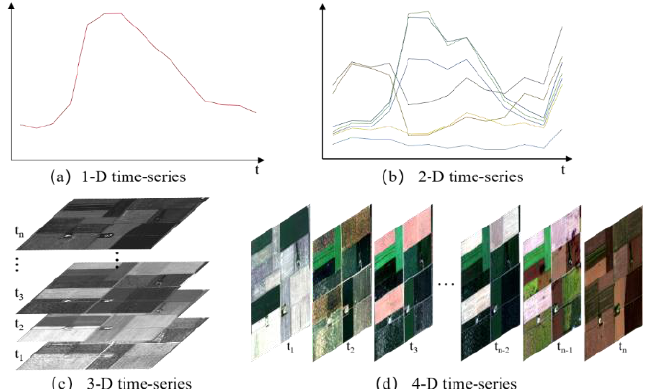
Figure 3. Time-series samples with different dimensions. ( a ) 1-D time-series, ( b ) 2-D time-series, ( c ) 3-D time-series, ( d ) 4-D time-series. ( c ) 3-D time-series, ( d ) 4-D